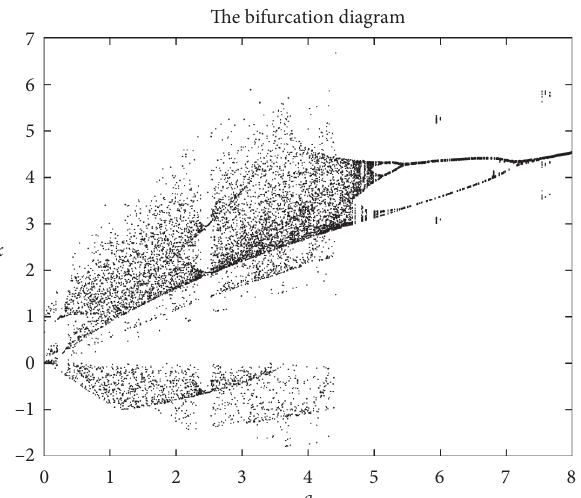
Figure 7: Bifurcation diagram of system (1) for 0 ≤ a ≤